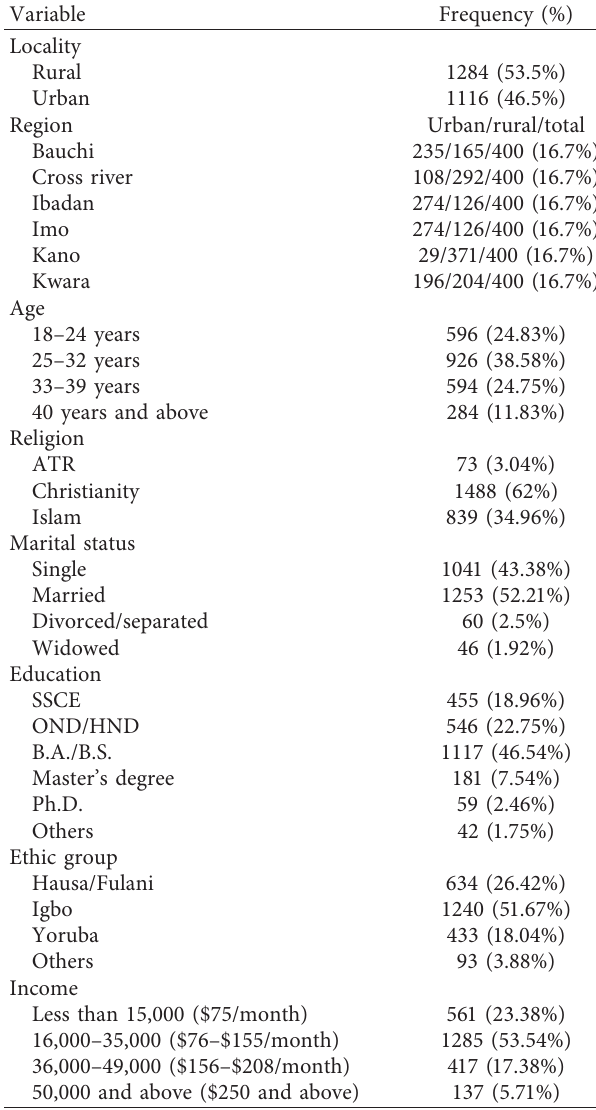
Table 1: Demographic characteristics of sample ( N �